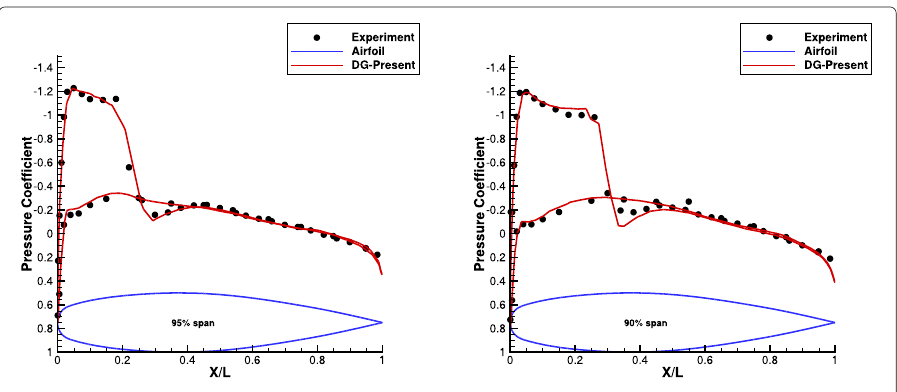
5.2.1 Inviscid flow at Ma=0.8395, α = 3.06 ◦ around the Onera M6 wings